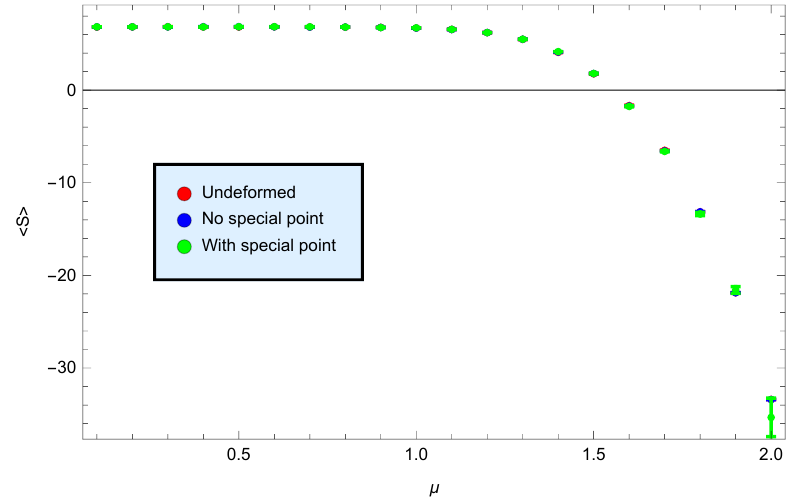
Figure 2 . Expectation values of the action for the same three contours. The results are consistent. In fact, for most values of µ one cannot distinguish the different points at the given resolution. This changes only around µ = 2 , where non-negligible error bars appear, due to the sign problem that is present in this case, for the contour with a special point.